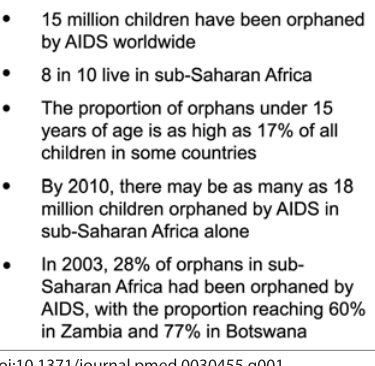
Figure 1. Orphans—Statistics and Predictions Data derived from [3,27,55].